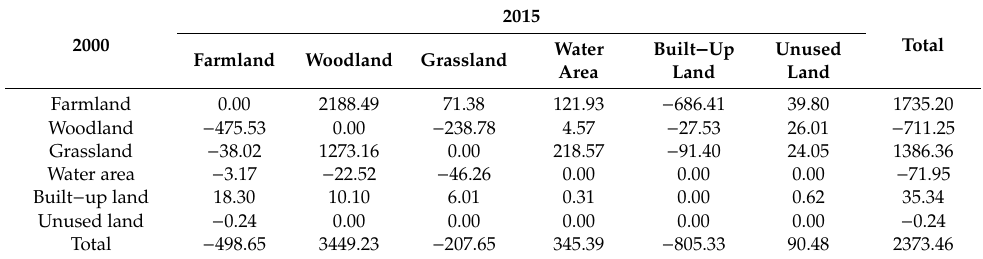
Table 6. Profit and loss of ecosystem service value in Shangzhou district from 2000 to 2015 (10 4 yuan).